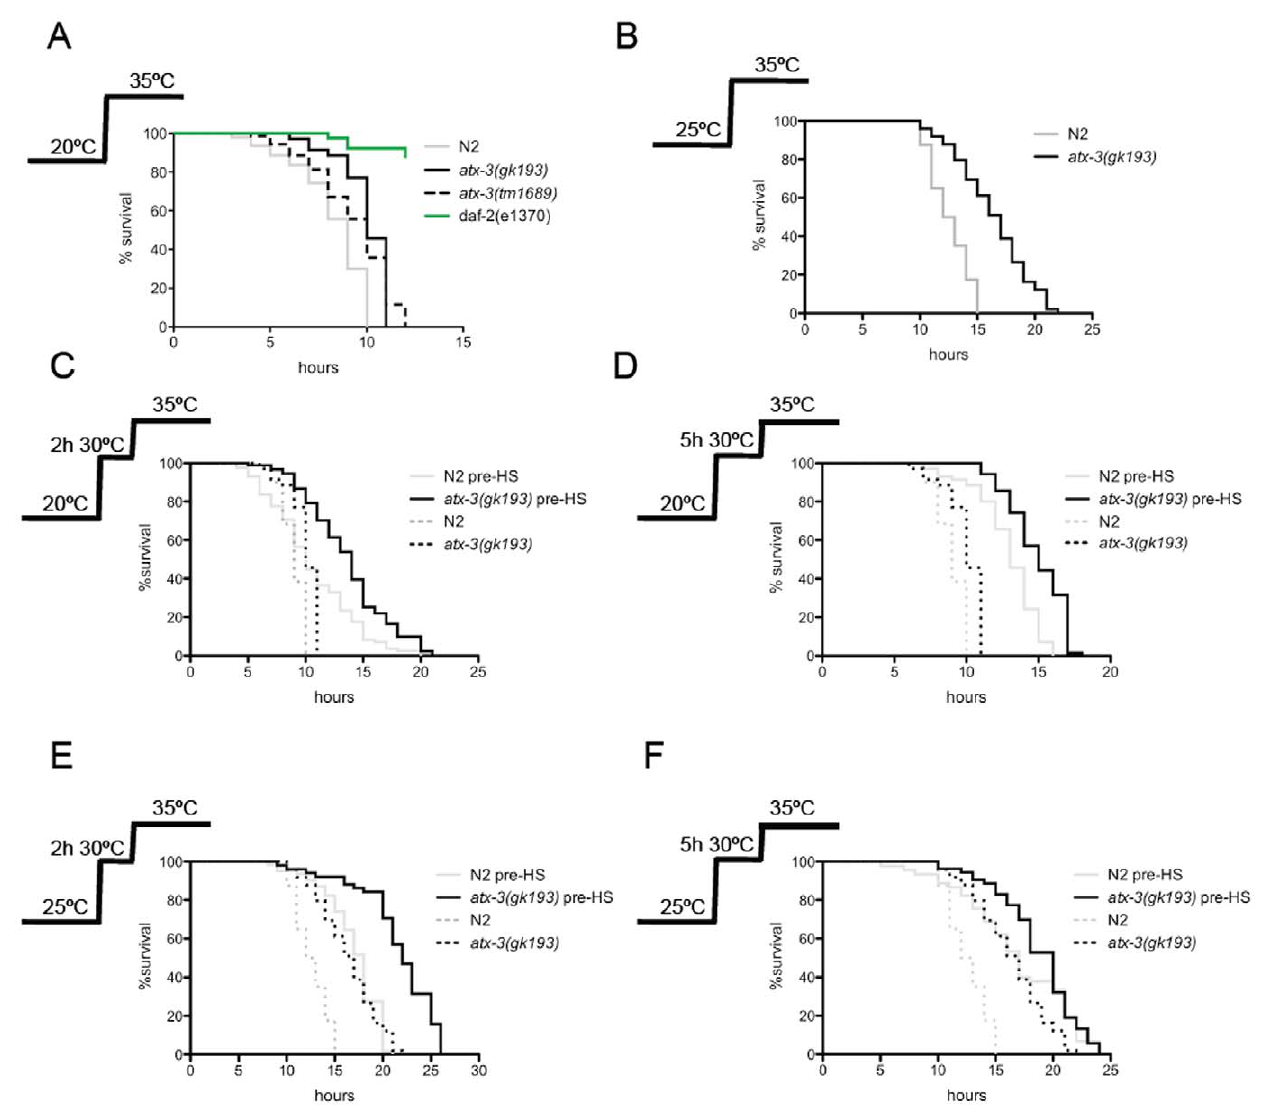
Figure 1. Atx-3 knockout animals are more resistant to heat stress than wild type. ( A ) Survival curves at 35 u C of wild type (N2) and atx-3 mutants ( gk193 , tm1689 ) previously grown at 20 u C (p , 0,0001). Median survival of N2 and atx-3 mutants is 9 h and 10 h respectively. ( B ) Survival curves at 35 u C of N2 and atx-3 mutantspreviously grown at 25 u C (p , 0,0001). Median survival of N2 and atx-3 mutants is 12.5 h and 17 h respectively (p , 0,0001). Pre-exposure to a non-lethal heat shock of 2 h ( C ) or 5 h ( D ) at 33 u C further enhances the thermoresistance phenotype of atx-3 mutants (p , 0,0001). Median survivals are: N2: 9 h, atx-3 : 10 h, N2 pre-HS 2h : 10 h, atx-3 pre-HS 2h : 14 h, N2 pre-HS 5h : 13 h, atx-3 pre-HS 5h : 15 h. The same trend is observed with animals previously grown at 25 u C (p , 0,0001) both with the 2 h ( E ) and 5 h ( F ) pre-HS. Median survivals are: N2: 12.5 h, atx-3 : 17 h, N2 pre-HS 2h : 18 h, atx-3 pre-HS 2h : 22 h, N2 pre-HS 5h : 17 h, atx-3 pre-HS 5h : 20 h. One representative experiment is shown (at least three independent replicates were